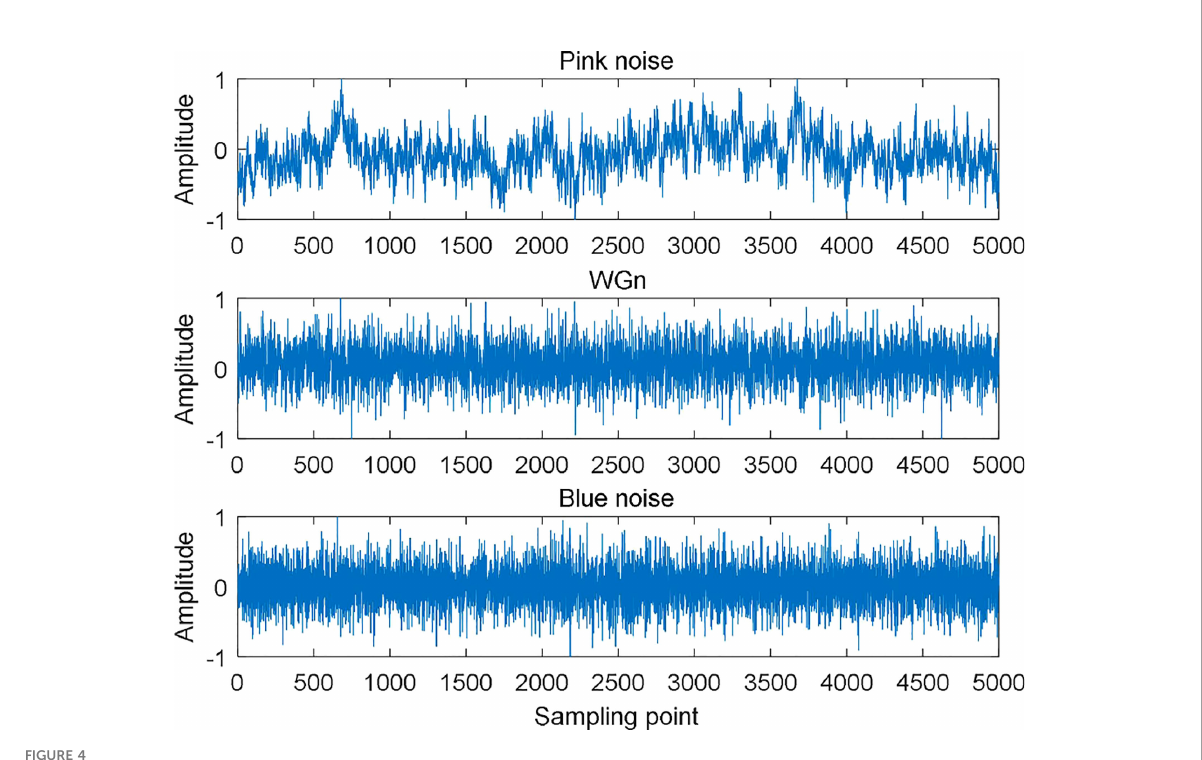
FIGURE 4 The normalized results of three types for noise